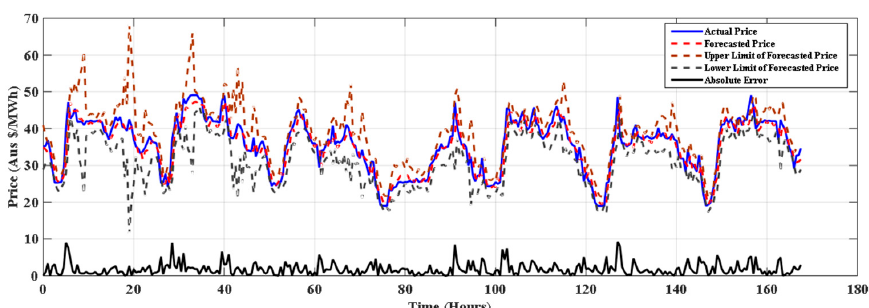
Figure 4. Forecasting for 22–28 October 2015 in spring with SMO regression+ FS. Table 6. Comparative daily MAPE corresponding to SMO regression and SMO regression +FS.